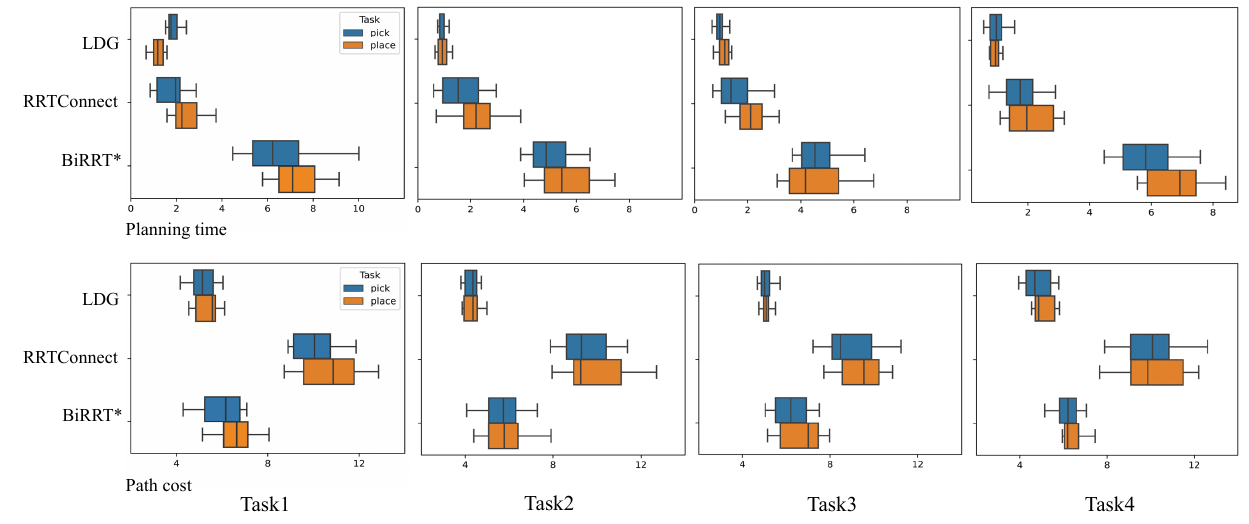
Figure 7. Experimental data obtained from the AUBO − i5 shelf stack tasks, which includes 4 times pick-and-place subtasks. Blue boxes and orange boxes are for pick-and-place tasks, respectively. To complete the manipulation task, each planner must plan a collision-free path to pick up the object and place it at the target location. The top boxplots represent the planning time, and the bottom boxplots represent the length of the planned path.